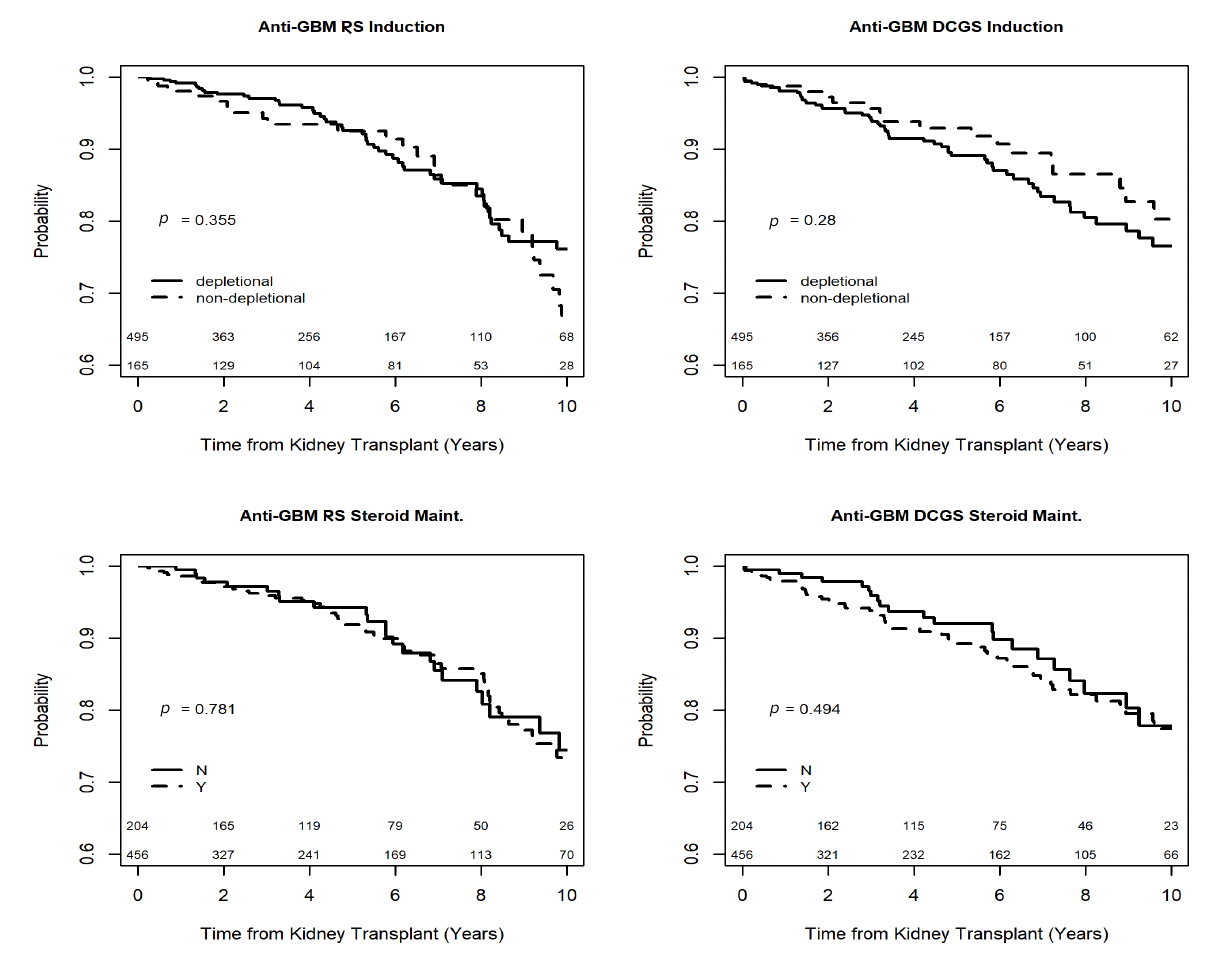
Figure 6. Univariable Kaplan – Meier Estimates of Recipient Survival (RS) and Death-Censored Graft